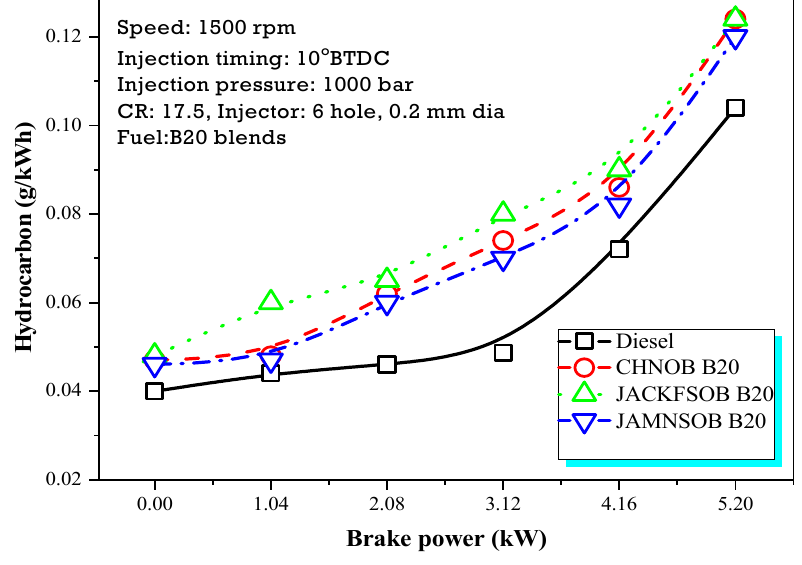
Figure 8. Variation of HCE vs. BP.